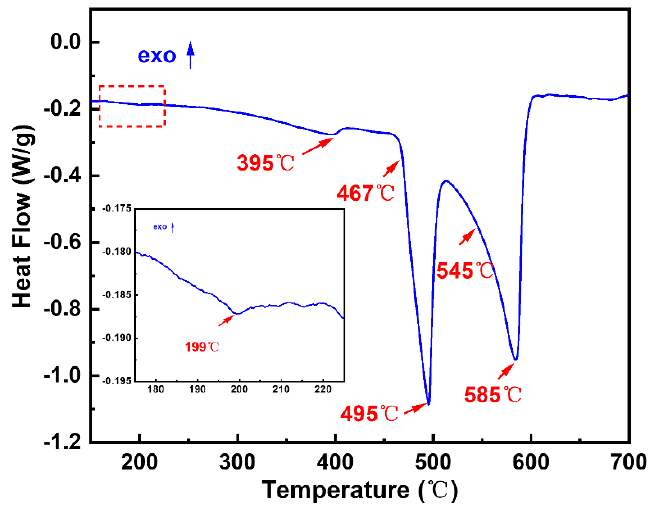
Figure 1. DSC curve of the as-cast 13Zn alloy.